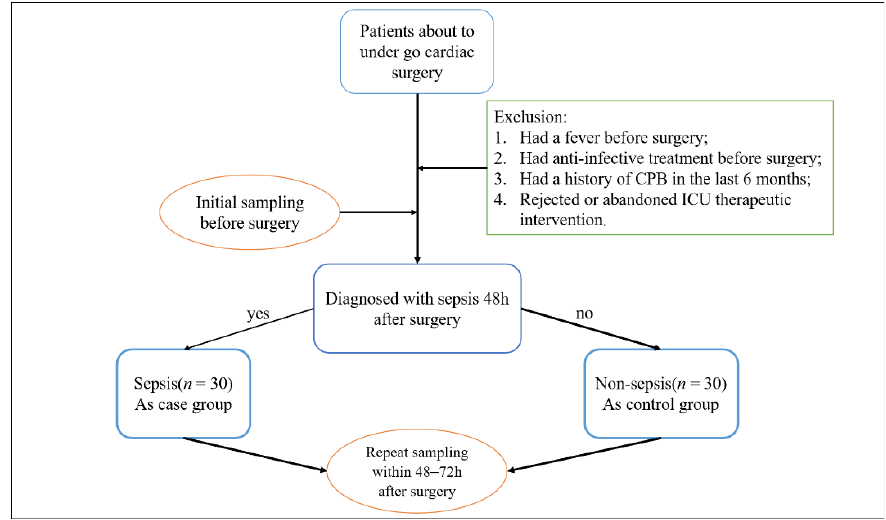
Figure 1. Clinical trial flowchart.